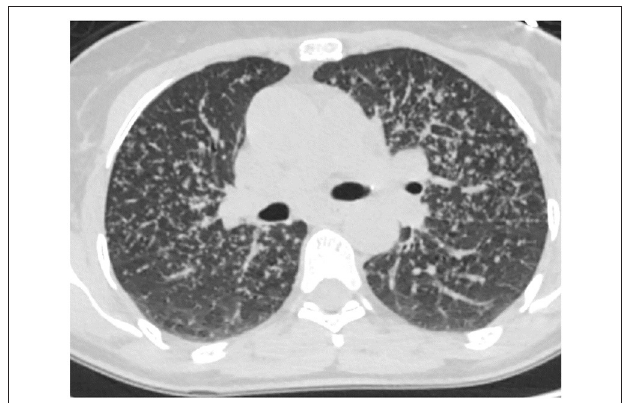
FIGURE 7 | Stage 4 sarcoidosis is associated with progressive loss of volume of the upper lobes with displacement of the right upper lobe bronchus posteriorly as seen in this image.